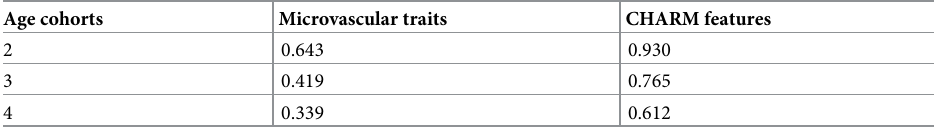
Table 6. Comparing traits to CHARM features in classification of age.